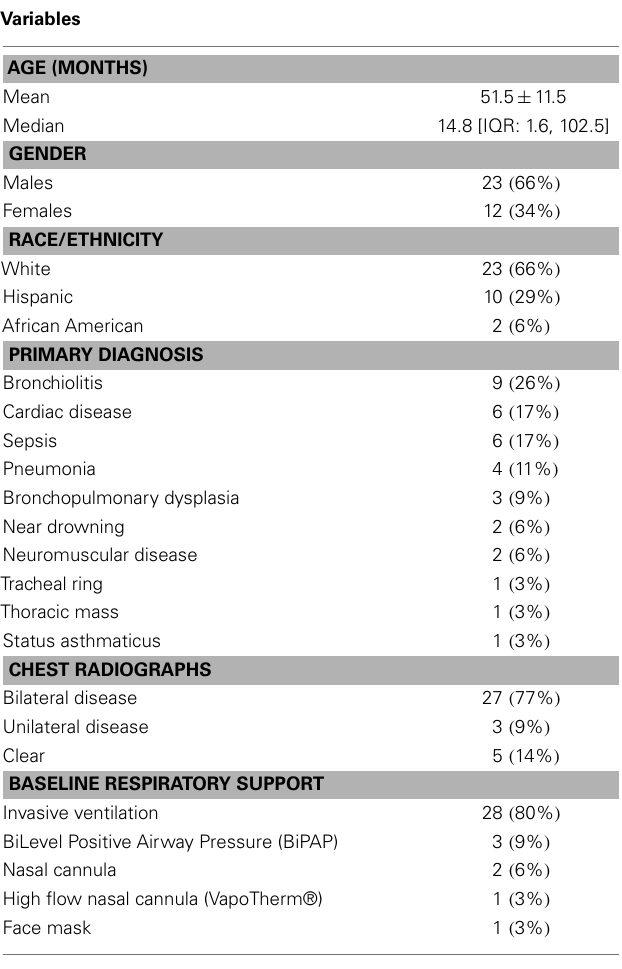
Table 1 | Baseline data of entire study cohort